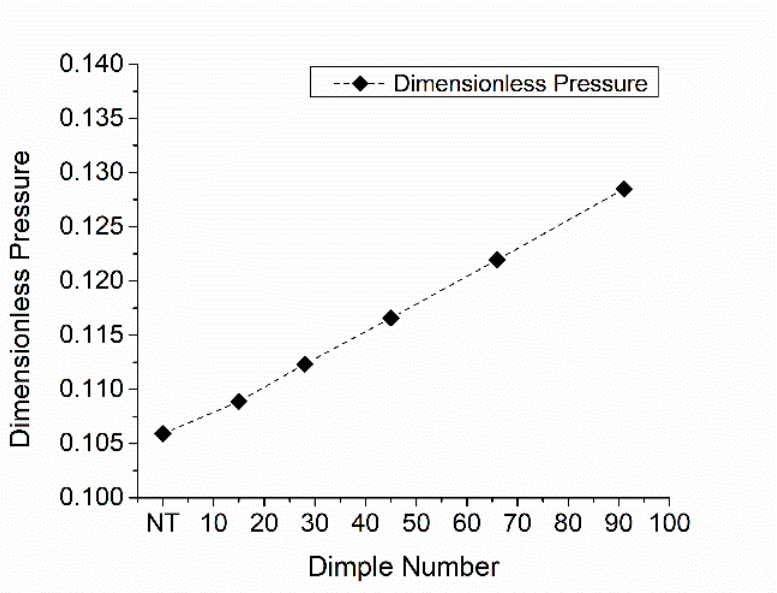
Figure 8. Average pressure on the top surface of the model for varying dimple densities (NT indicates the non-textured case).